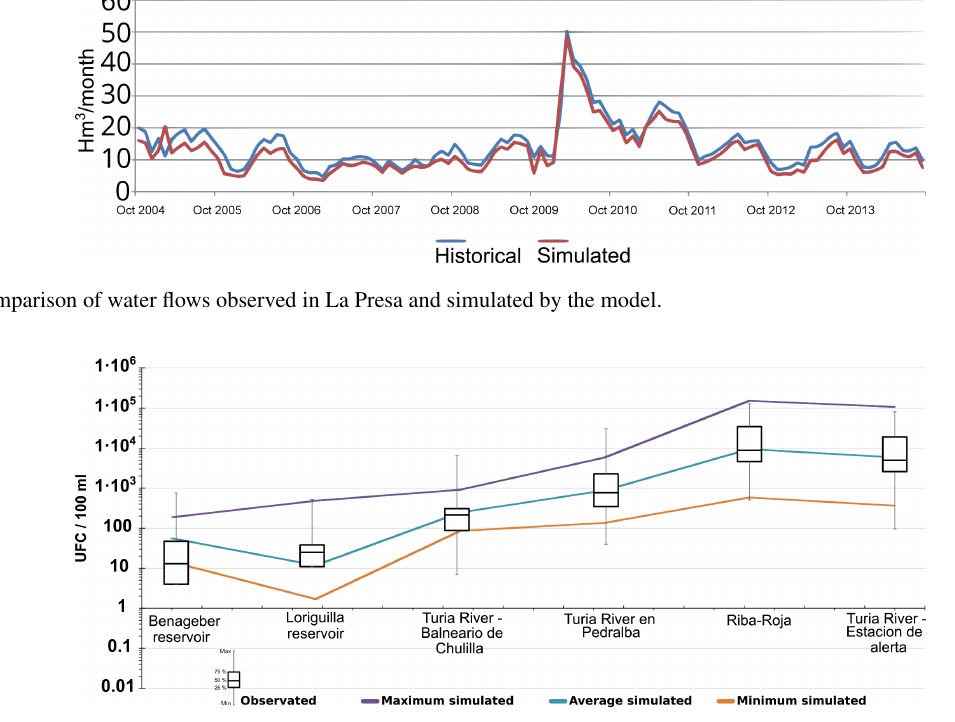
Maximum, average and minimum concentrations